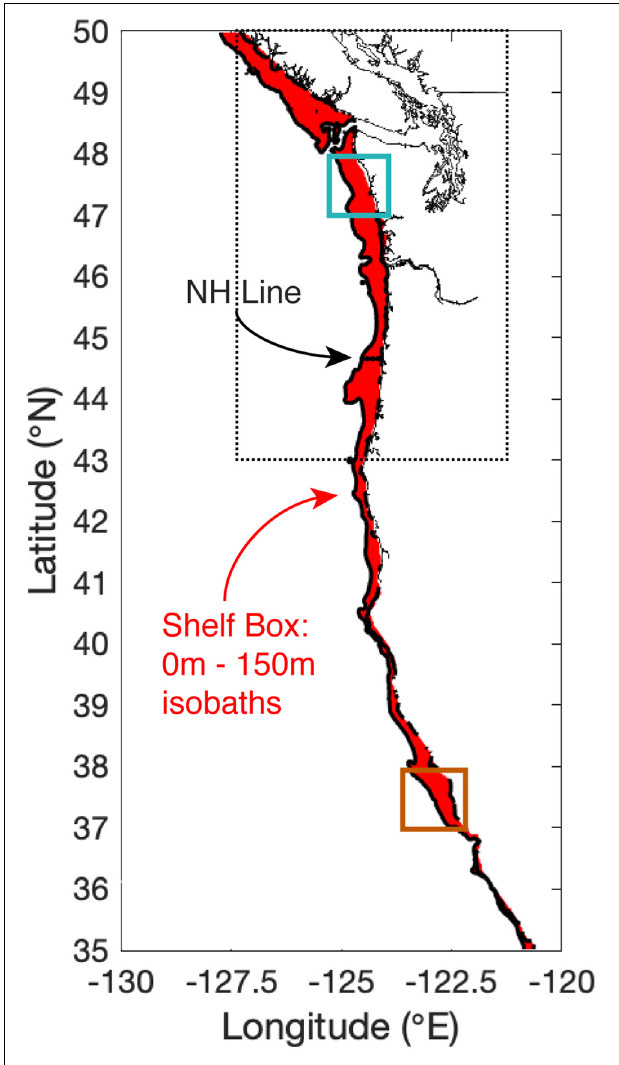
FIGURE 2 | Study domain for the chlorophyll concentration and wind stress satellite data. The shelf (0–150 m isobaths) is shown in red. The Cascadia model domain used during the particle tracking experiments is outlined by the dashed line. Examples of latitude shelf boxes are shown in orange and cyan for 37.5 ◦ N (37–38 ◦ N) and 47.5 ◦ N (47–48 ◦ N), respectively. Black dots mark locations along the Newport Hydrographic Line used for satellite chlorophyll validation in Figure 4